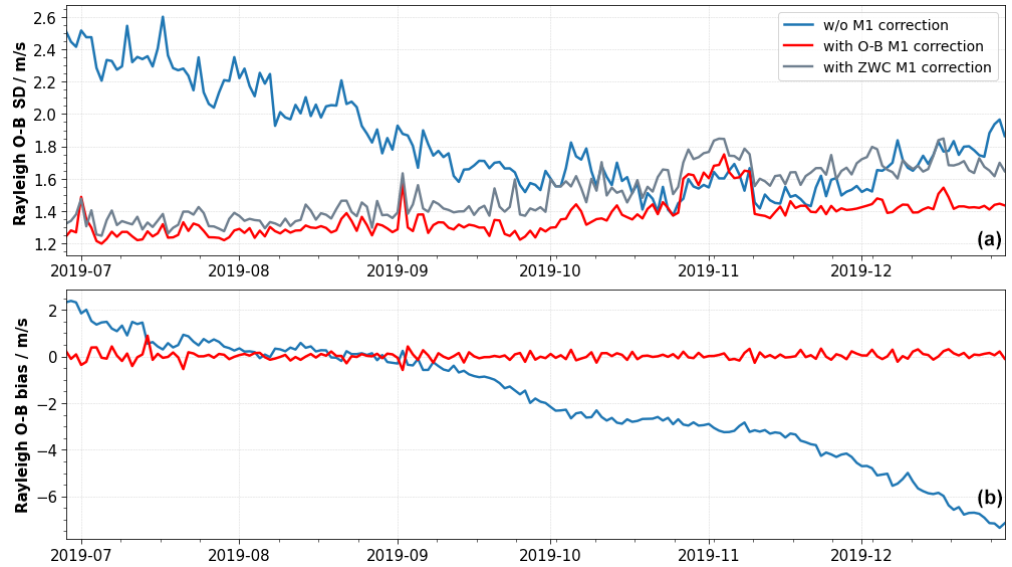
Figure 13. Performance of the O − B (red) and ZWC M1 bias correction (grey) methods for the period from 28 June to 31 December 2019. (a) Time series of daily averages (15 orbits) of the standard deviation (SD) of the Rayleigh clear E(O − B) HLOS values before (blue) and after the O − B - and ZWC-based M1 correction (red and grey, respectively). (b) Daily averages of the bias of the Rayleigh clear E(O − B) HLOS values before (blue) and after the O − B -based M1 bias correction (red). Data from day N are used to predict the bias on day N +